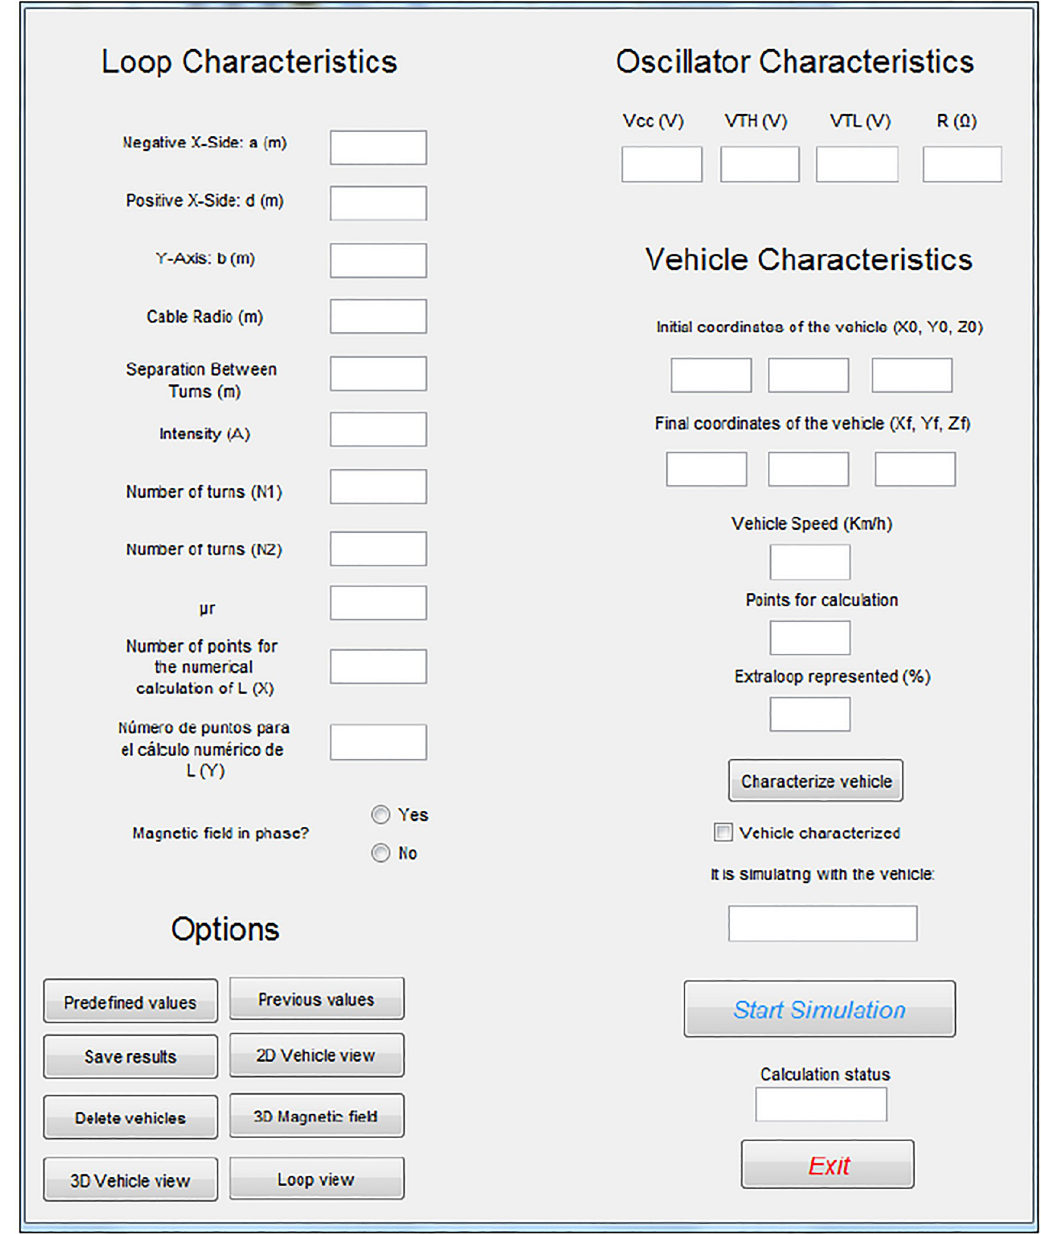
Fig 13. Program that allows the characterization and simulation of vehicles passing over any type of loop to obtain their magnetic profiles.